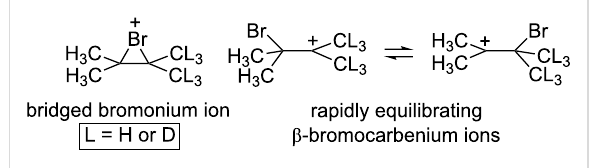
Figure 4: The tetramethylbromonium ion system